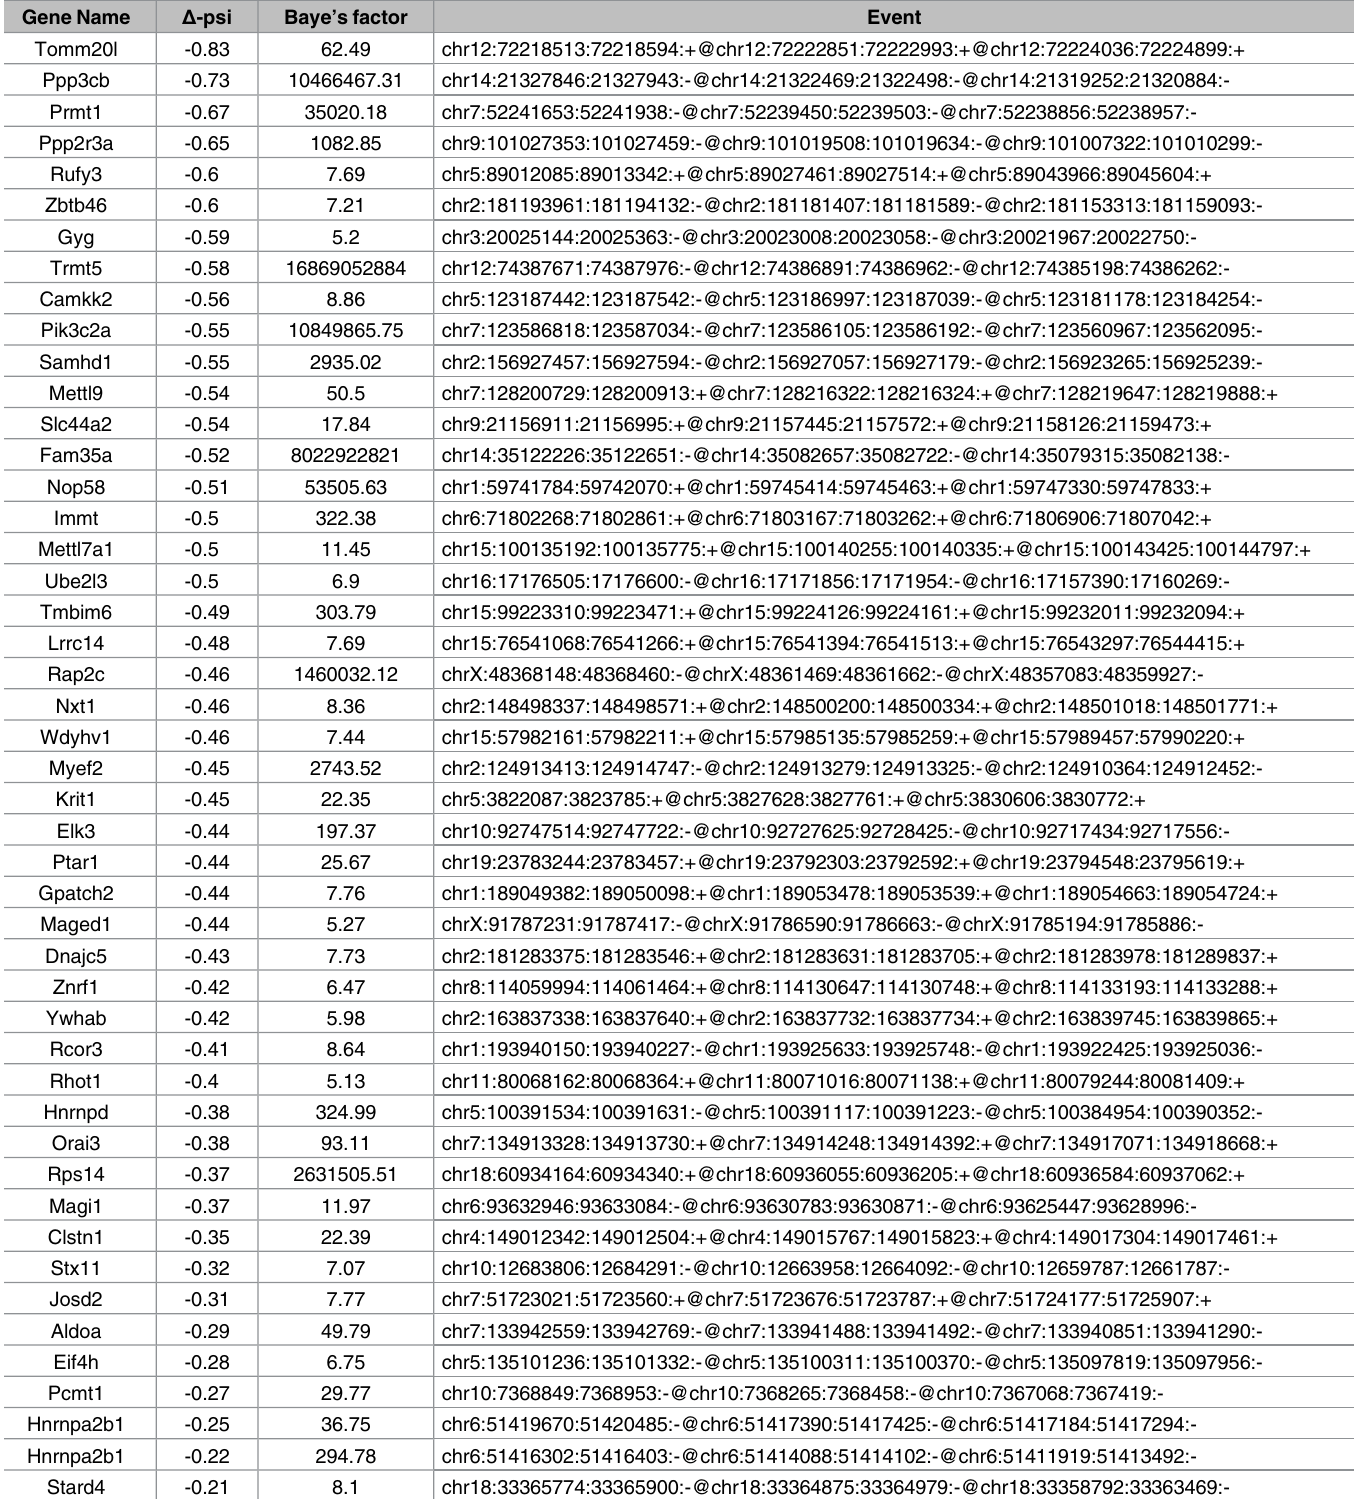
Table 1. SMN-dependent exon skipping events ranked by percent